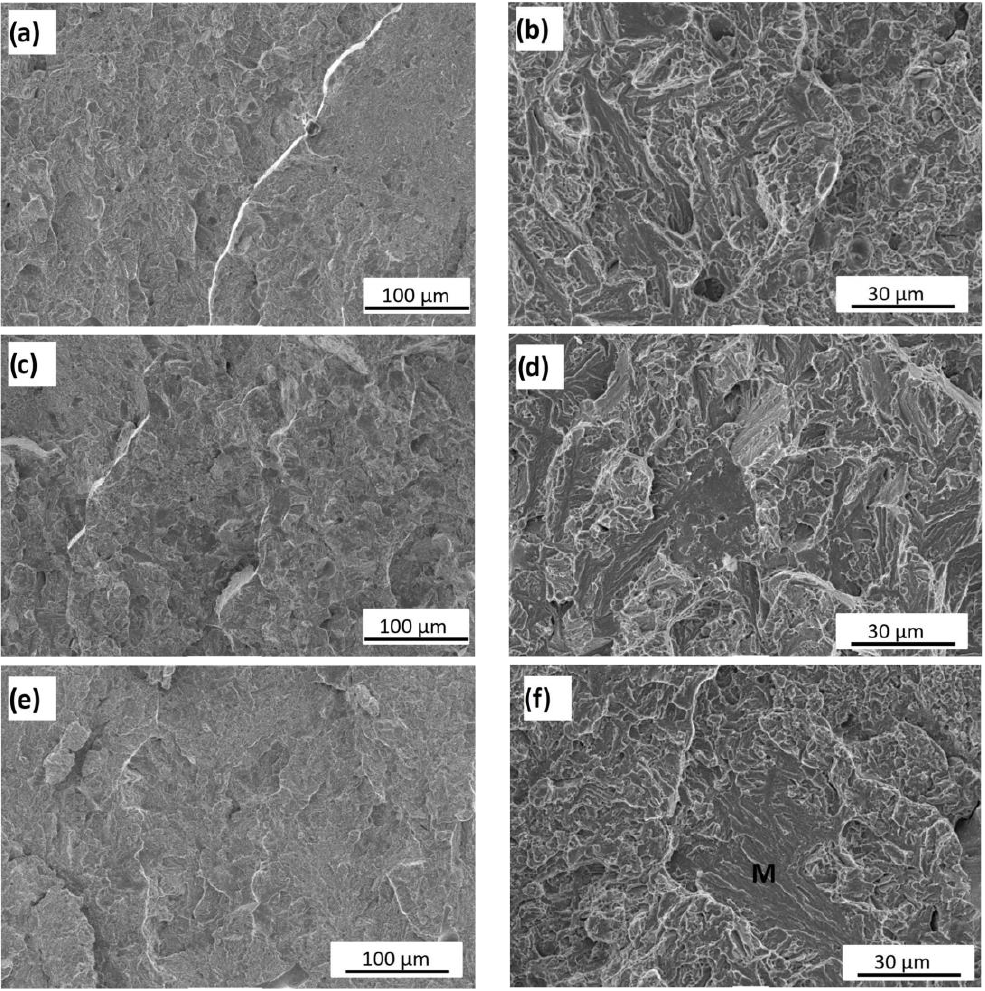
Figure 18. SEM micrographs showing fracture surface of Charpy samples: ( a , b ) transformed at 280 °C, ( c , d ) transformed at 330 °C, and ( e , f ) transformed at 380 °C.